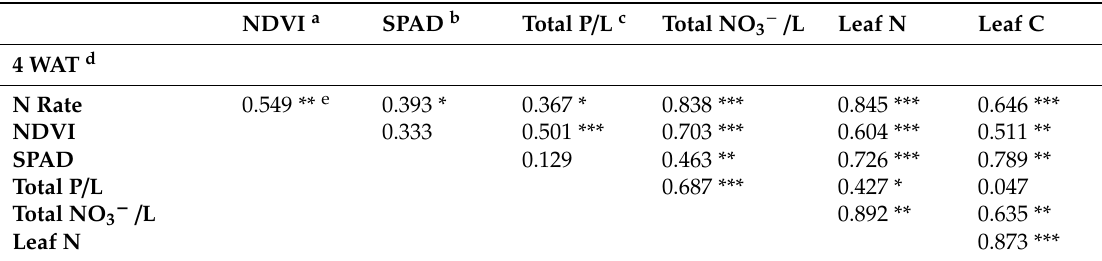
Table 2. Bivariate correlation of all recorded parameters throughout the study at sampling times 4, 8, and 12